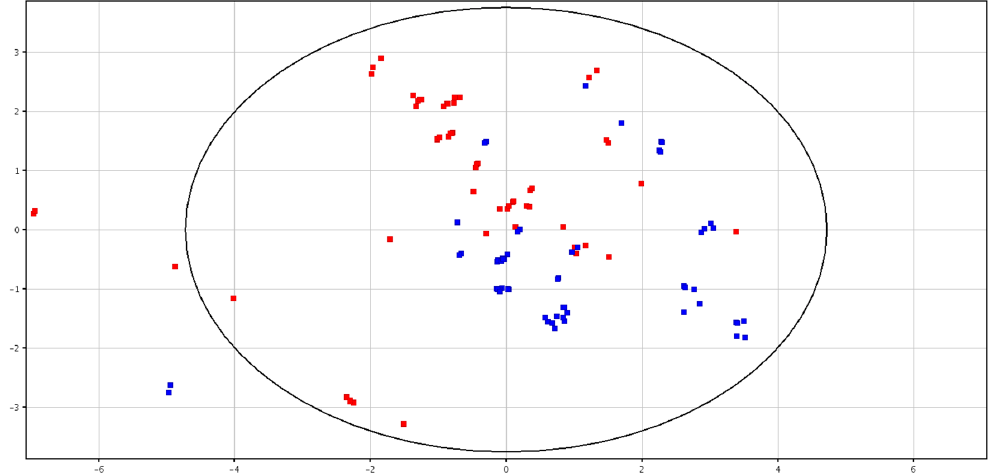
Figure 2. PCA scores plots of the LC–MS data acquired for fresh (in blue; F-S) and cryopreserved (in